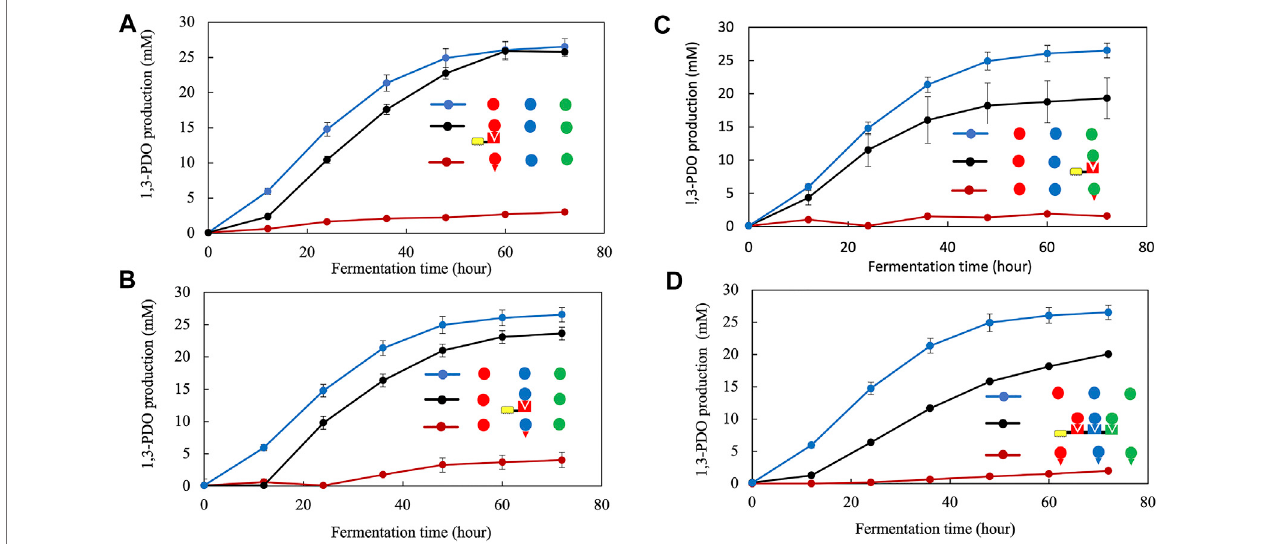
FIGURE 3 | Effect of interactions between the cohesin module and the dockerin module on the activity of dhaB1 (A) , dhaB2 (B) , dhaT (C) . Effect of interactions of the full length scaffoldin and the dockerin modules on the activity of the complete dhaB1, dhaB2, dhaT pathway (D) . All symbols are described in Figure 1 . Standard deviation is shown as vertical bars for each data